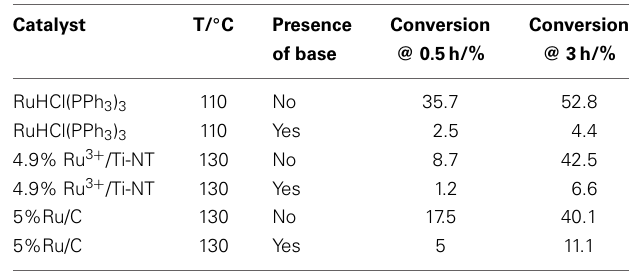
Table 3 | Effect of the presence of base NaOMe on the isomerization of